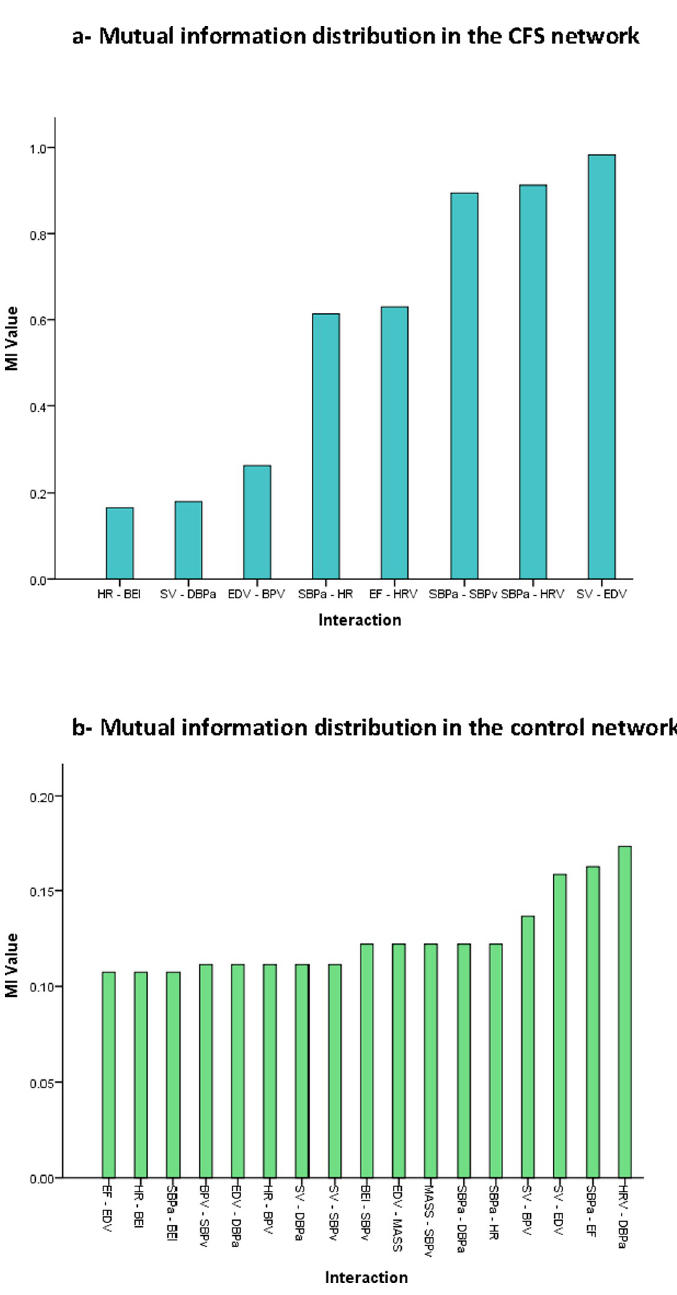
Fig 2. Mutual information distribution in a) the CFS network b) control network. Edge shade is related to MI between nodes. Darker edges indicate a stronger link. Abbreviations: BEI- Baroreflex effectiveness index, BPV- Blood pressure variability, EDV- End diastolic volume, EF- Ejection fraction, HR- Heart rate, HRV- Heart rate variability, MASS- End diastolic wall mass, SBPa- Mean systolic blood pressure during active stand, SBPv- Mean systolic blood